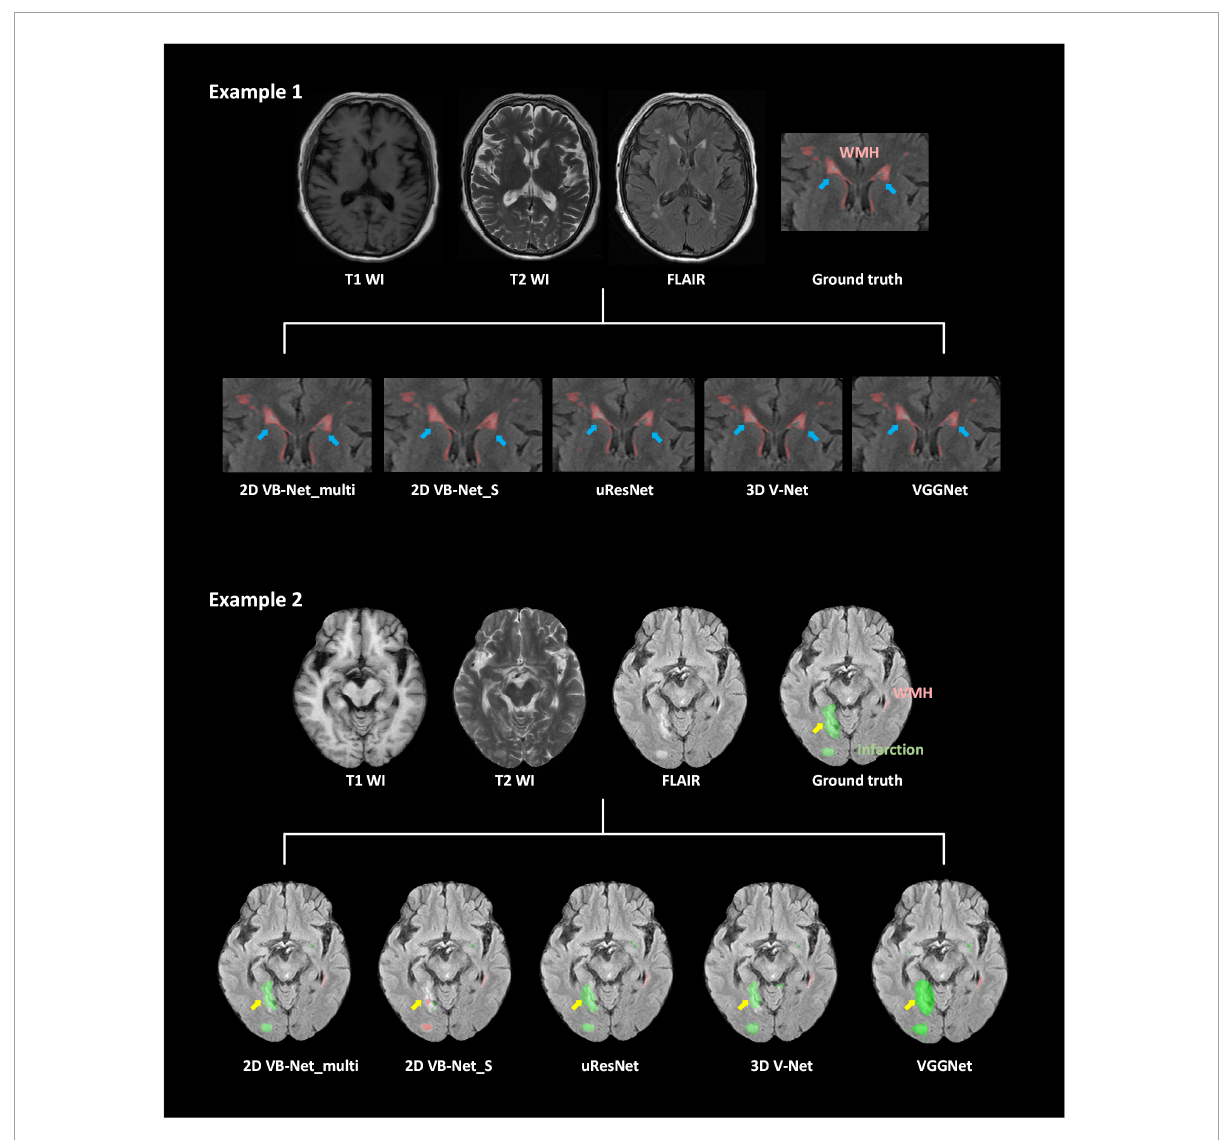
FIGURE4 Examples of different segmentation methods used to illustrate the segmentation of WMH and cerebral infarction. The blue arrows show hyperintensities adjacent to the bilateral anterior horn of lateral ventricles on the FLAIR sequence. A portion of these hyperintensities is located in the lateral ventricles because of the partial volume effect, which was misidentified as WMH by using the 2D VB-Net_S algorithm. The yellow arrows indicate cerebral infarctions located in the brain areas of the cortex and cortical-subcortical junction. The 2D VB-Net_S algorithm misidentified these lesions as WMH. All the other algorithms correctly identified the stroke lesions, and the 2D VB-Net_multi algorithm provided better segmentation than the other three state-of-the-art